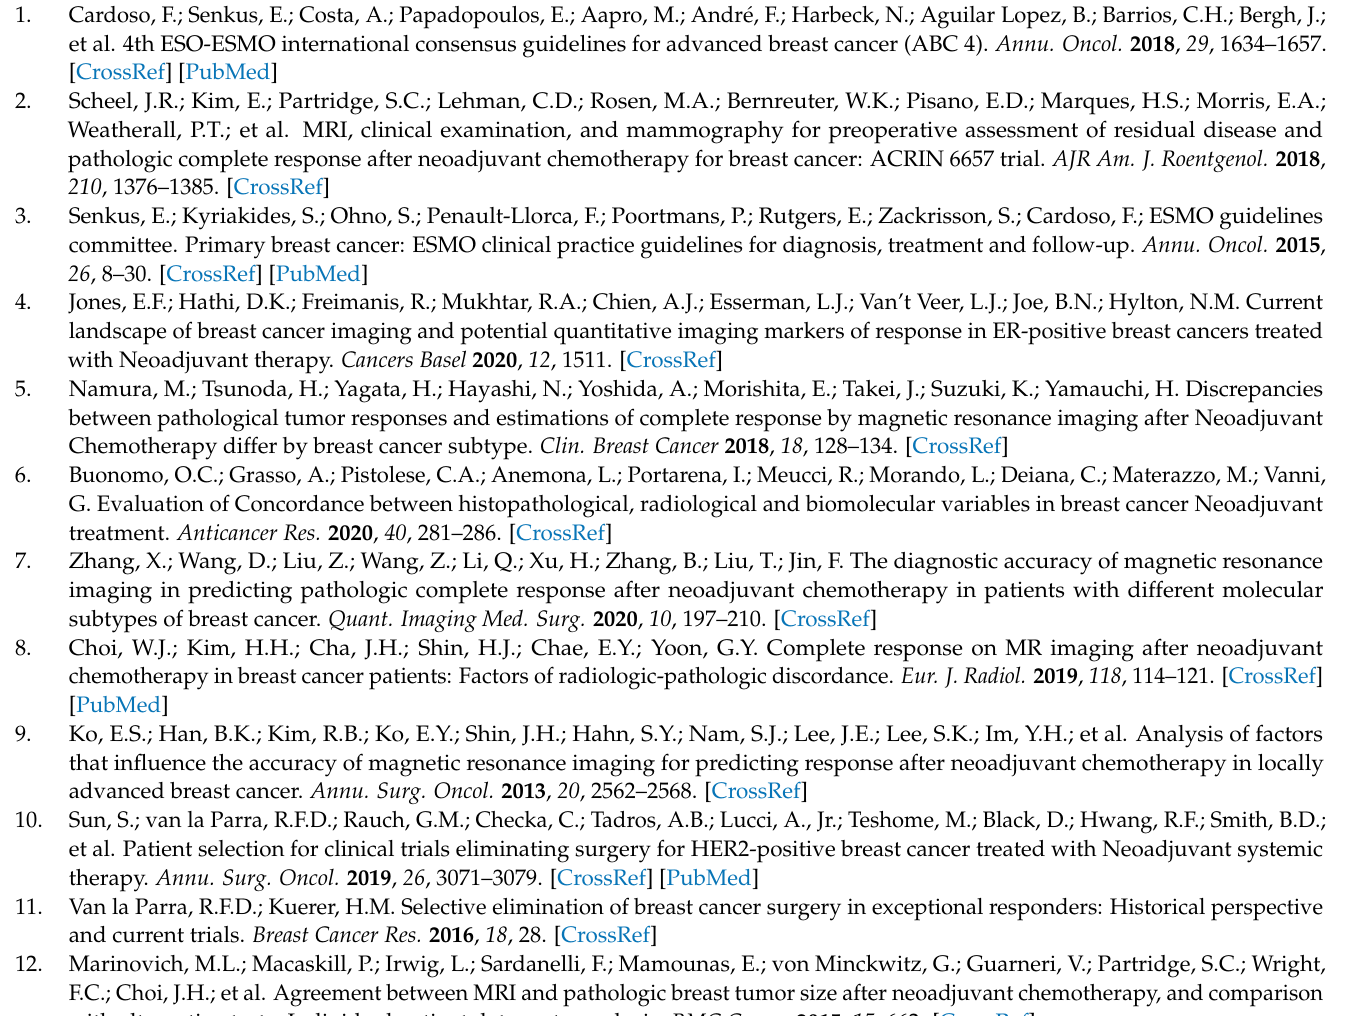
calcifications. Figure S2: False positives for both the combined and the CE evaluation, Figure S3: False negative for both the combined evaluation and the CE